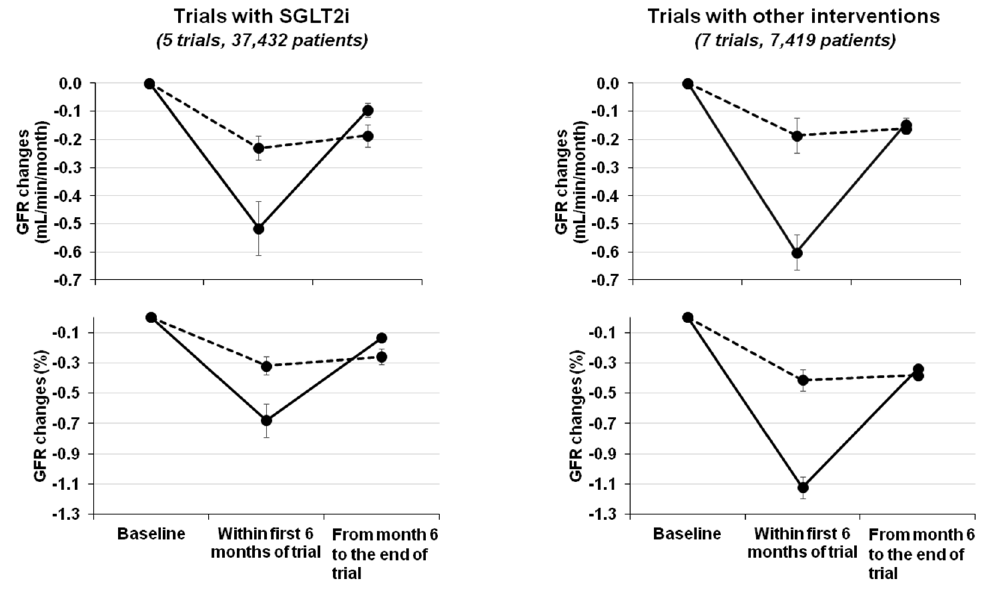
Figure 1. Check-mark sign in randomized trials reporting GFR values by period of follow up. Solid line represents changes in active arm, while dotted line refers to placebo arm. Trials are described in Table 1. GFR decline is absolute (upper panel) or percentual (lower panel) and calculated from baseline to the first 6 months and from 6 months to the end of trial. Absolute changes are calculated as weighted means in order to take into account the di ff erent sample size in trials, and are expressed as mL / min / month to take into account the di ff erent timing of GFR assessment in di ff erent trials. The initial period occurred after 5.1 ± 1.5 months and end of trial after further 43.3 ± 17.8 months for trials with SGLT2i and after 5.6 ± 3.1 months and end of trial after further 41.6 ± 13.8 months for trials with other interventions.